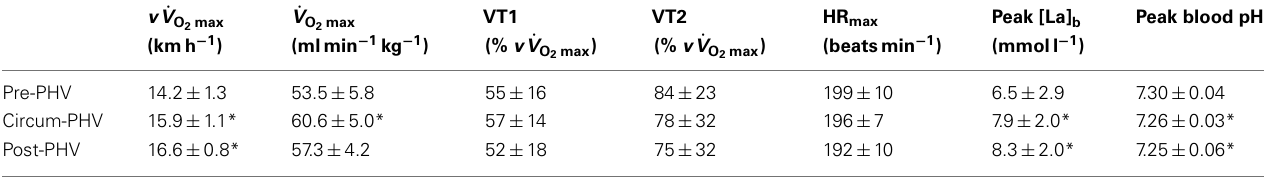
Table 2 | Cardiopulmonary fitness and running performance of highly trained young soccer players grouped according to maturity status.